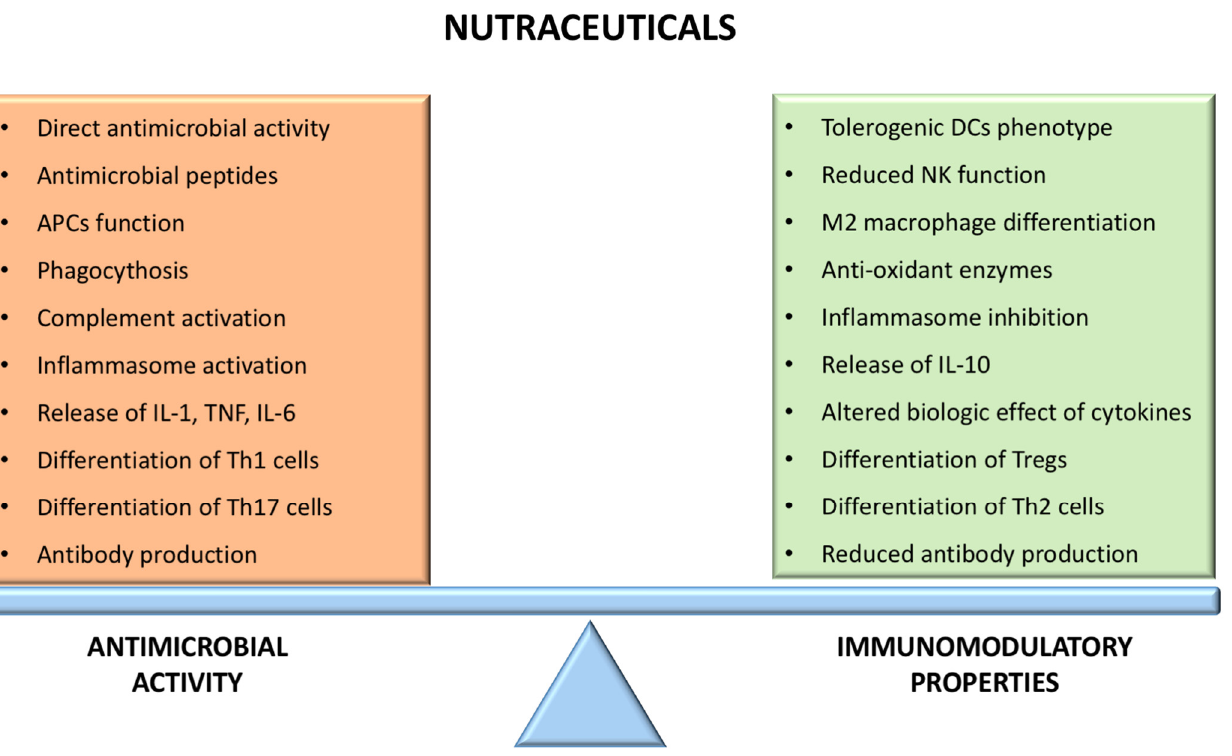
Figure 2. Action of nutraceuticals on the immune balance.